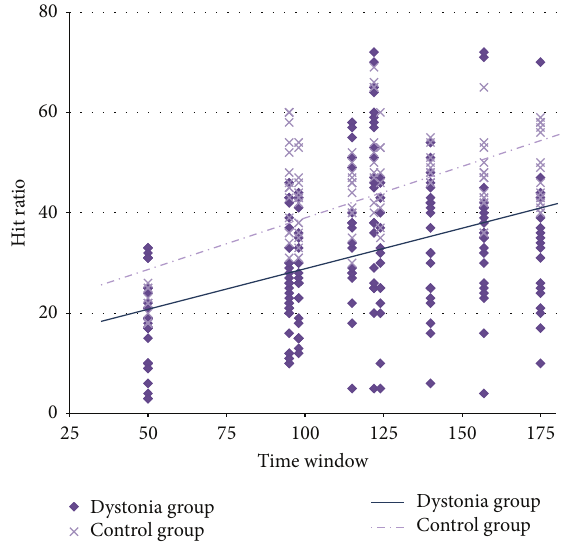
Figure 7: The effect of response window width and hit ratio. The relationship between hit ratio (percentage) and window width (milliseconds) for the two